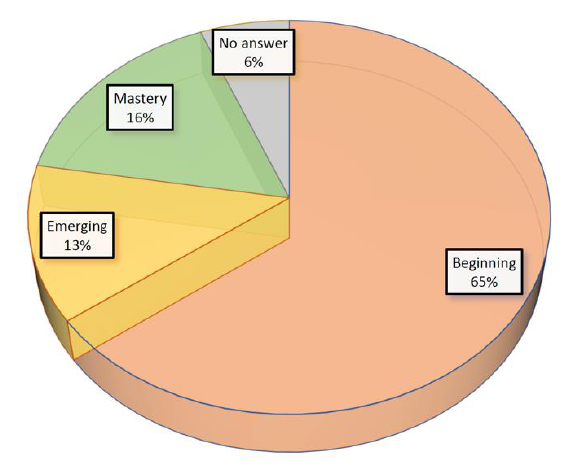
Figure 2. Results obtained from the analysis of activity 1.